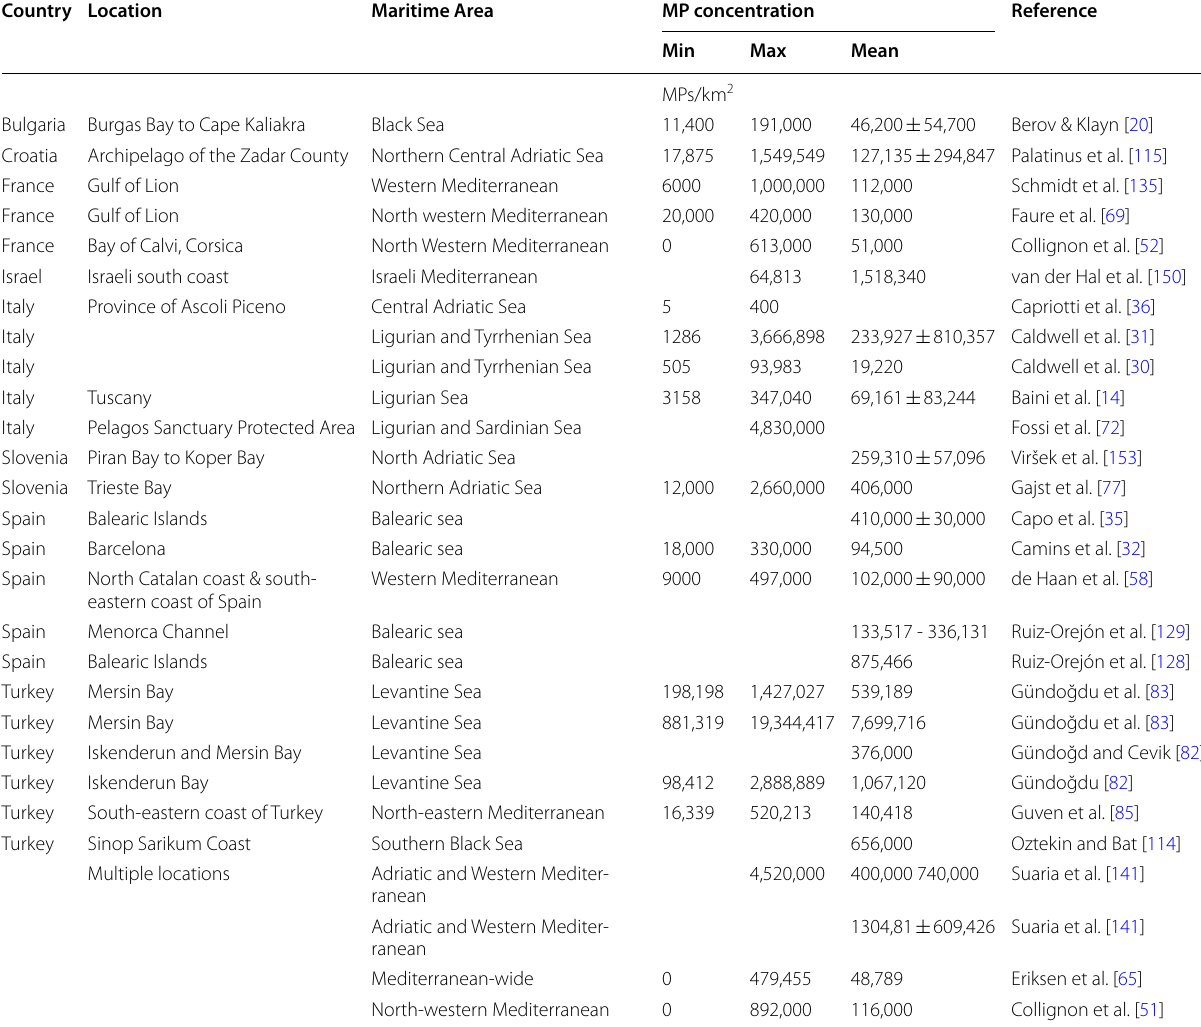
Table 5 Summary of microplastic concentrations in Mediterranean seawater (MPs/km 2 ; all surface water samples) Country